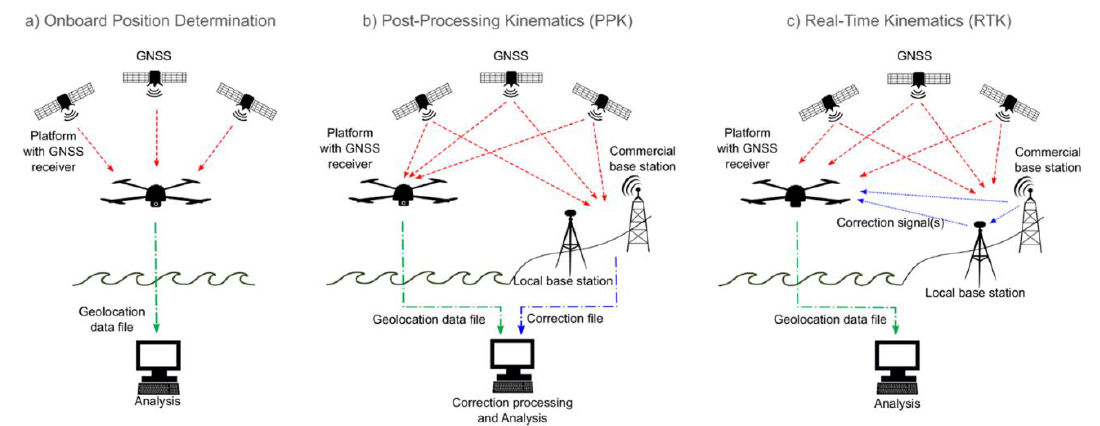
Figure 8. The three methods used to acquire geolocational data in RS using UAVs and manned aircraft (labeled “platform” in the figure). ( a ) Platform location is determined using trilateration of three or more satellite signals. ( b ) Platform location is determined by the user applying a correction to the Global Navigation Satellite System (GNSS) receiver-generated location file. The correction file is downloaded from either a local base station operated by the user or from a commercial base station operated by external parties, such as governments. ( c ) Platform location is determined by applying a correction signal from a base station concurrently to data acquisition.